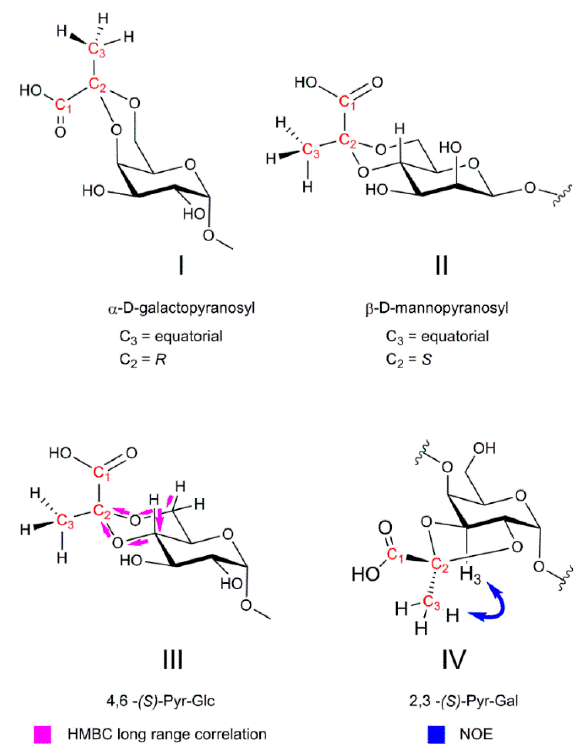
Figure 4. I and II , equatorial-oriented methyl groups of 4,6 galacto - and manno -pyranosyls. III , identification of the attachment site of pyruvylation via hetero multiple bond correlation (HMBC). IV , through-space correlation of the pyruvate methyl group to a ring proton—in this case H 3 . Pink arrows indicate though-bond interactions of neighbouring protons (HMBC), while blue arrows indicate through-space interactions of neighbouring protons (NOE).